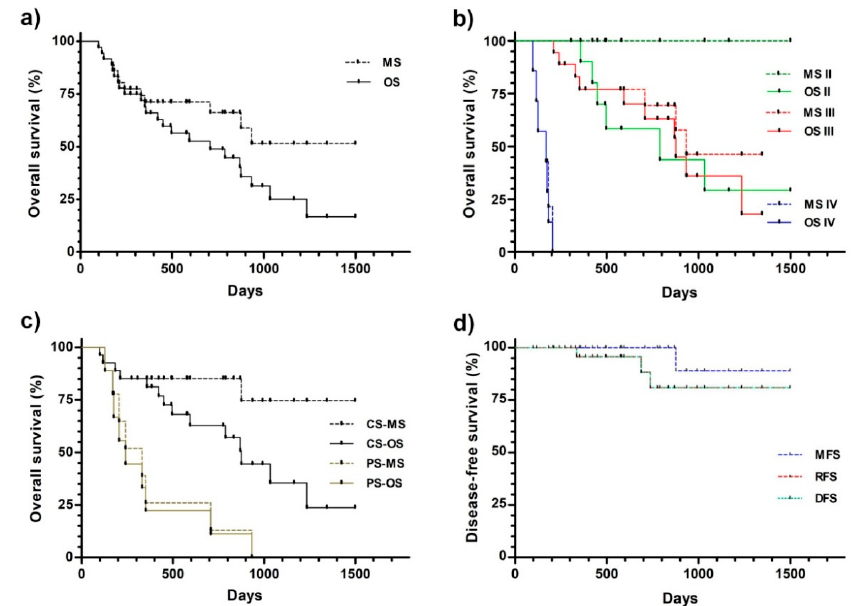
Figure 3. Kaplan–Meier analysis of the overall ( a – c ) and disease-free ( d ) survival. ( a ) All of the patients were considered as a single group. ( b ) The patients were grouped by the initial